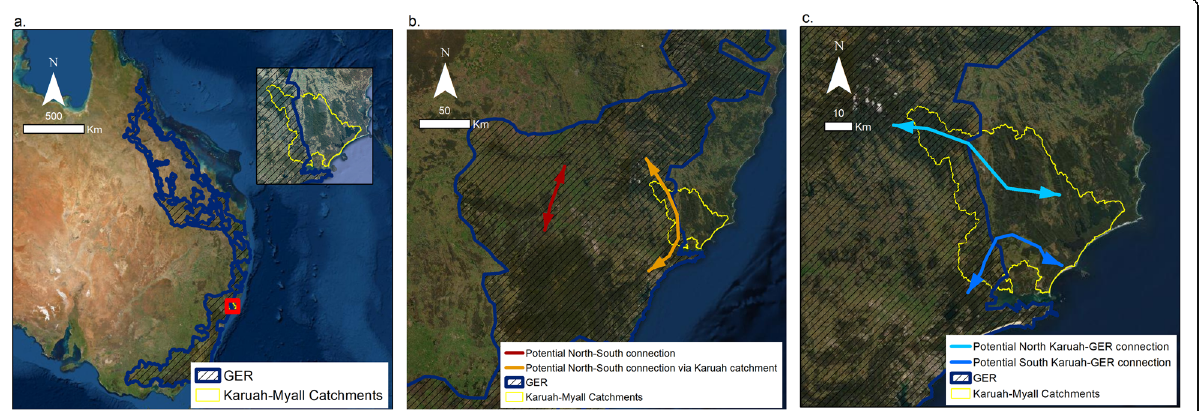
Fig. 9 a Extent of the Great Eastern Ranges and the location of the Karuah-Myall catchments. b Hypothetical North-South connection between the Karuah-Myall catchments and the GER. c Hypothetical pathways denoted by arrows showing how Karuah-Myall catchments supports movement between coastal patches within the study area and the